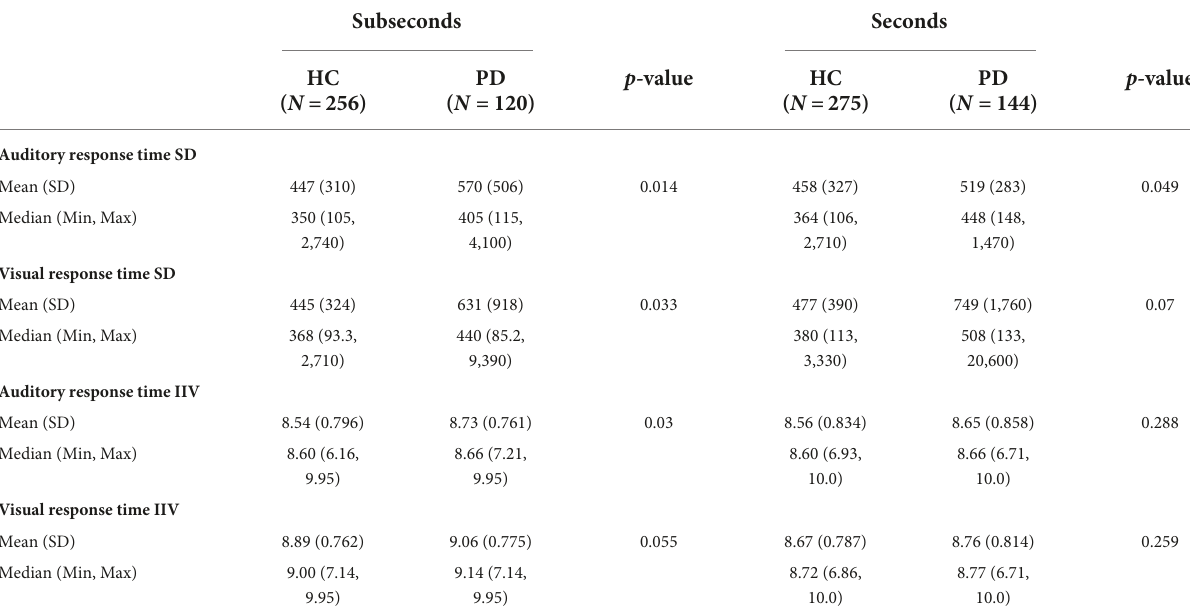
TABLE 2 Standard deviation (SD) and intra-individual variability (IIV) of response time in HC and PD groups responding to auditory and visual stimuli in the seconds and subseconds